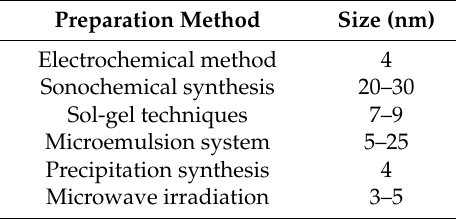
Table 1. The synthesis of CuO NPs with different methods results in different sizes